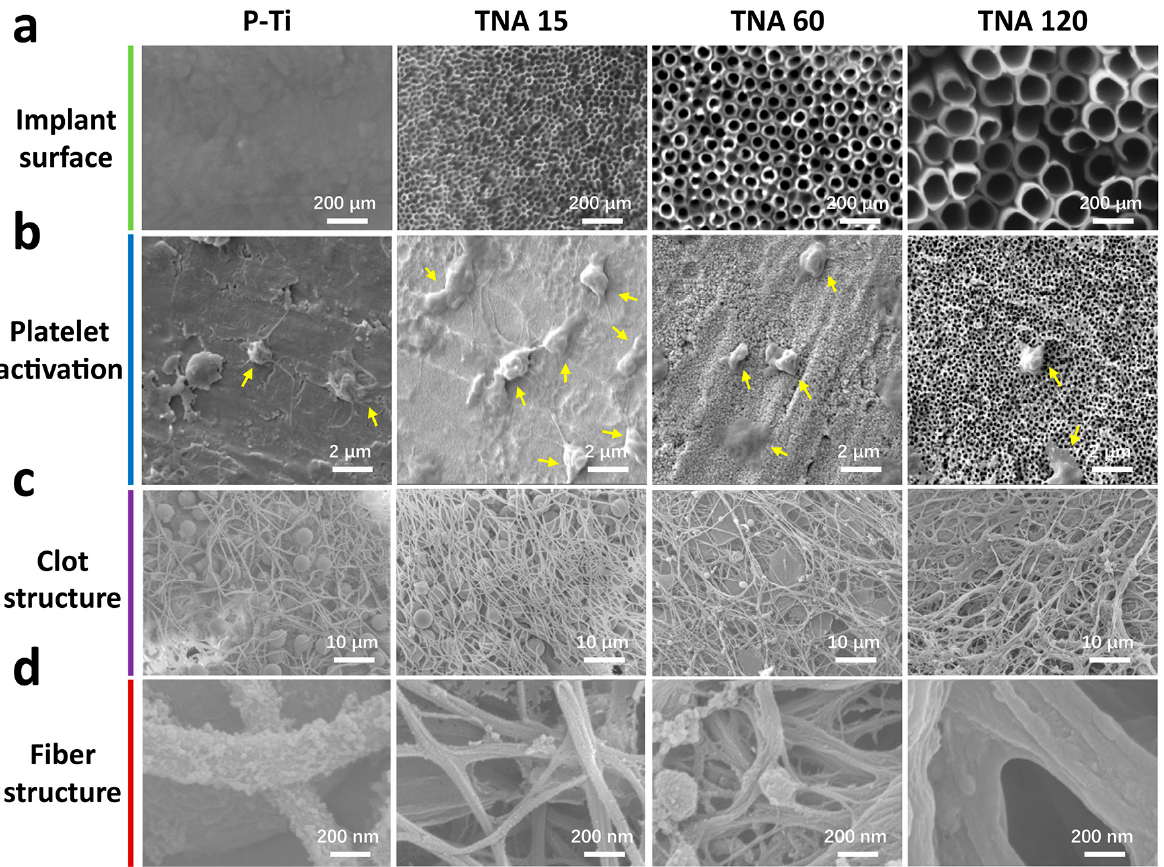
Figure 1. ( a ) Scanning electron microscope (SEM) images of the surface of P-Ti and TNAs. ( b ) Platelet activation (yellow arrows) on the surfaces. ( c , d ) Clot and fiber structures on the surfaces.